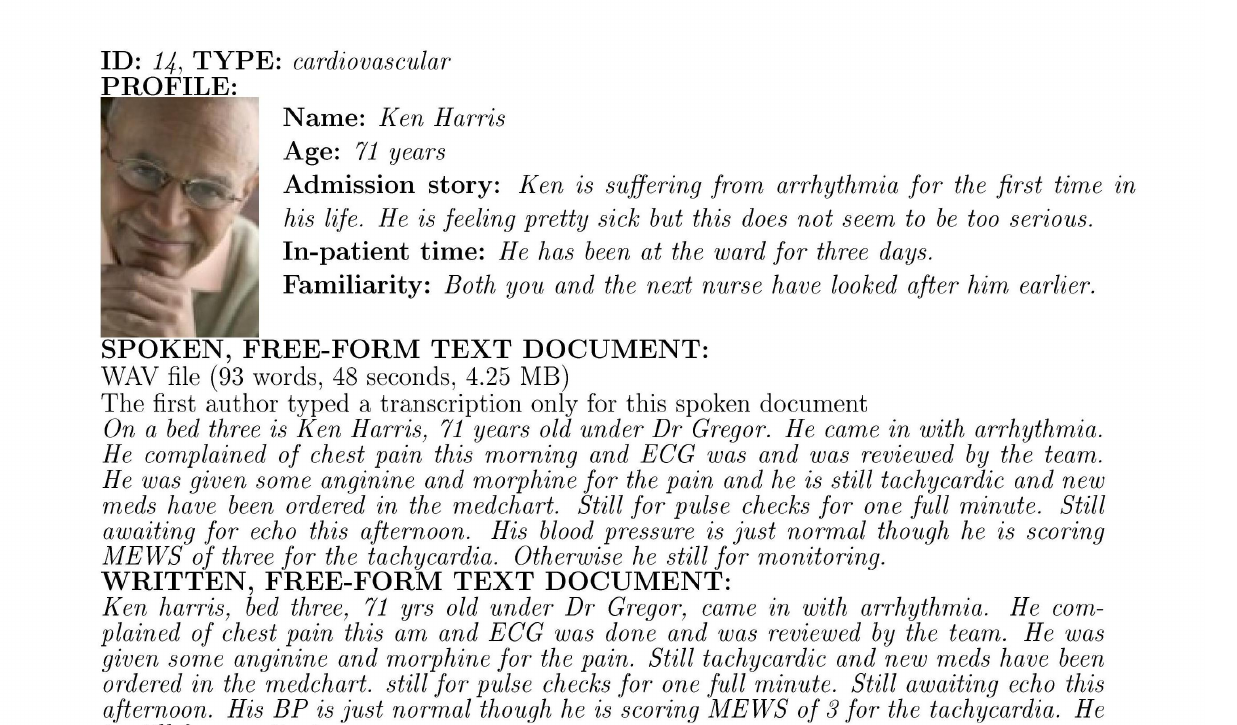
Figure 1. An example record that originates from our